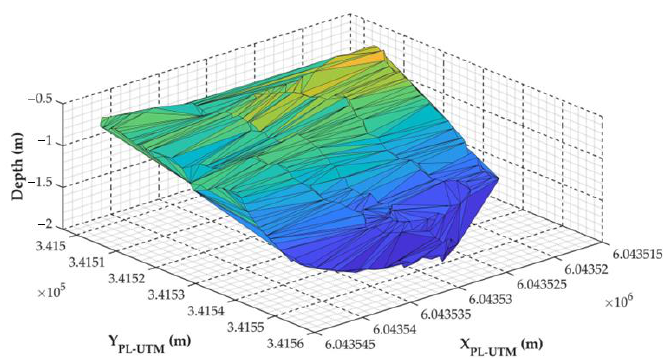
Figure 4. Seabed of the waterbody No. 1 in the form of a TIN.